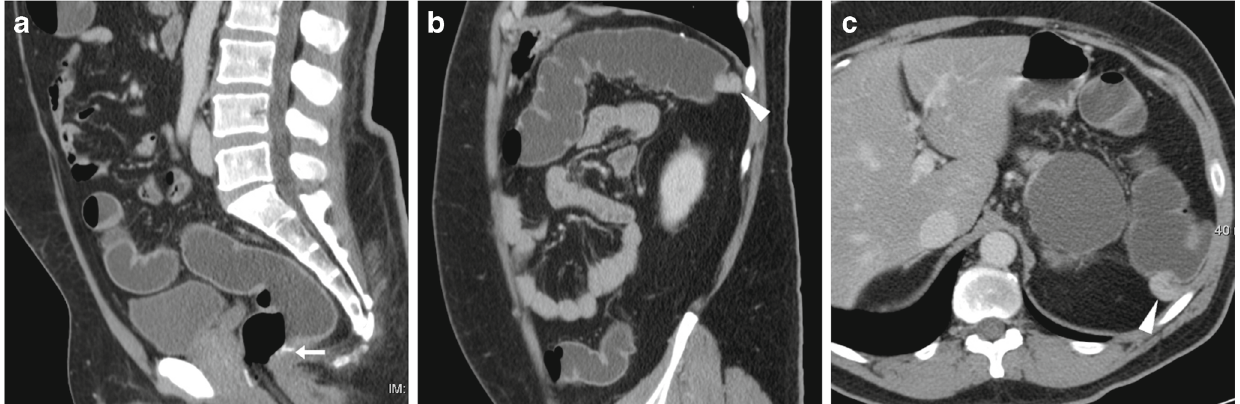
Fig. 7 Assessment of postsurgical positioning of large bowel in a 40- year-old male with rectal prolapse repair, history of splenectomy and distal pancreatectomy for neuroendocrine tumour. Following incomplete colonoscopy, WE-MDCT showed a normally positioned